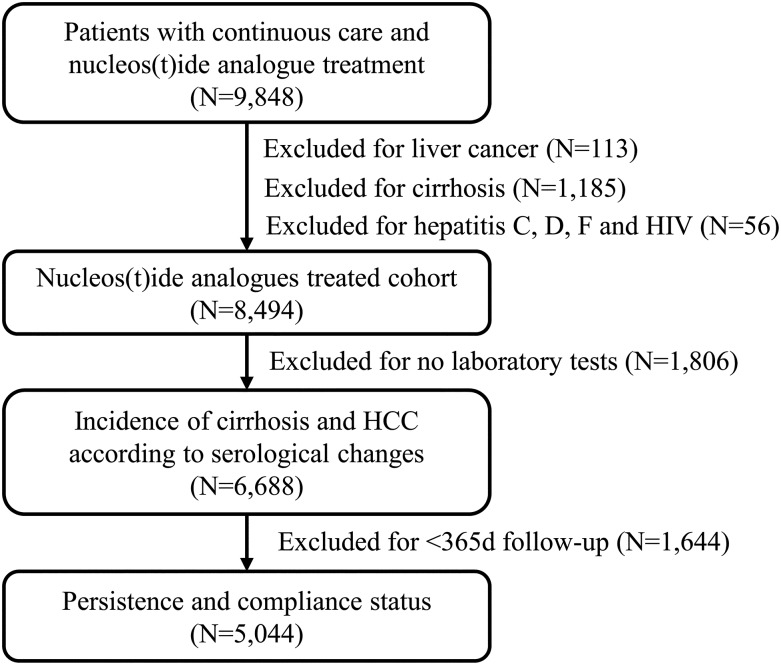
Flow chart of the study cohort